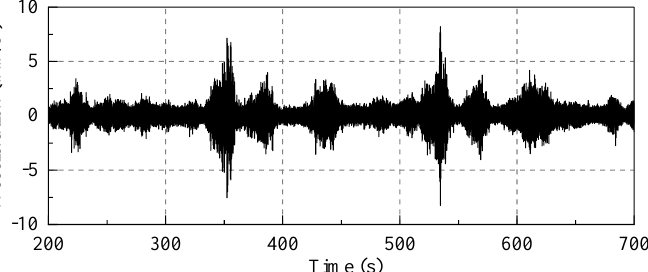
Figure 15. The time − history of acceleration of the third floor measuring point (D − P2) in the east − west direction.